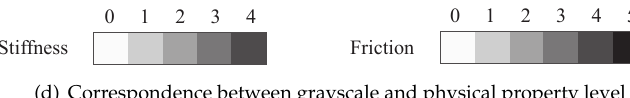
Figure 2. The first and third rows of ( a ) are RGB images, and the second and fourth rows are their corresponding ground truths. Ground truths are weakly labeled, that is, they are only labeled according to the terrain types. ( b ) The corresponding relationship between the terrains and the annotation colors. ( c ) The physical property ground truths of the test set. ( d ) The correspondence between grayscale and physical property level. The values of friction coefficient and stiffness corresponding to the friction levels and stiffness levels are presented in Section 2.3.